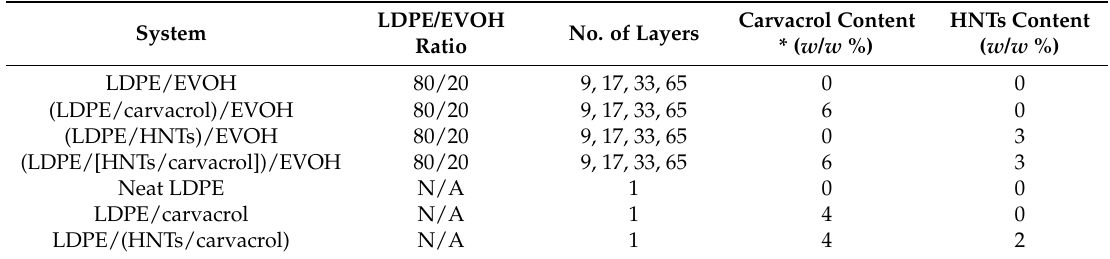
Table 1. Composition of the studied multilayered films. The thickness of all films was maintained constant at 100 µ